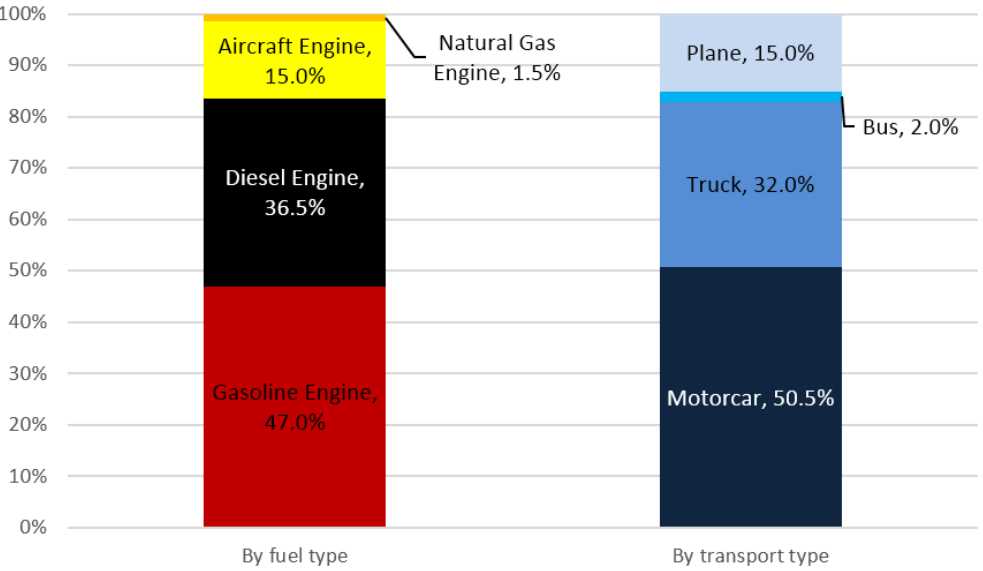
Figure 16. The structure of energy consumption in the transportation sector in Malaysia in